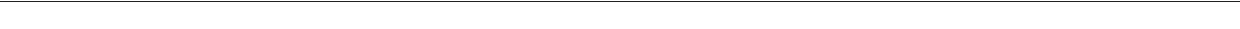
Fig. 2 Phylogeny and ATP transport by Microsporidia and Rozella NTTs. a NTT phylogeny for the Microsporidia/ R. allomycis clade of endoparasitic fungi inferred under the CAT + GTR model in PhyloBayes. The tree is the posterior consensus tree inferred under the CAT + GTR model, in which all relationships with posterior support <0.5 were collapsed. Branch lengths are proportional to the expected number of substitutions per site. Scale bar = 0.5 changes per site. A single-ancestral acquisition of a bacterial NTT gene is inferred in the common ancestor of Microsporidia and Rozella followed by independent gene duplications and family expansion during the radiation of Microsporidia. The NTTs that were functionally characterised in this study are indicated, including the two ancestral NTTs shown at the base of the tree. Support values are Bayesian posterior probabilities. b Uptake of [ 32 P]-ATP by E. coli cells expressing NTTs for 30 min. All NTT gene and species names are given. ATP uptakes for all NTTs were signi fi cantly different ( p < 0.05, one-way ANOVA) to the pET16b control. c Kinetics of [ 32 P]-ATP uptake in E. coli expressing NTTs from E. bieneusi (EbNTT1 – 4) or R. allomycis (RaNTT1). d Substrate saturation curves for [ 32 P]-ATP to determine K m and V max for NTTs from T. hominis (ThNTT1 – 4), E. bieneusi (EbNTT1 – 4), and R. allomycis (RaNTT1). Curves were fi tted to the Michaelis – Menten equation and the K m and V max were calculated by iteration. All data points represent means ± SD of at least